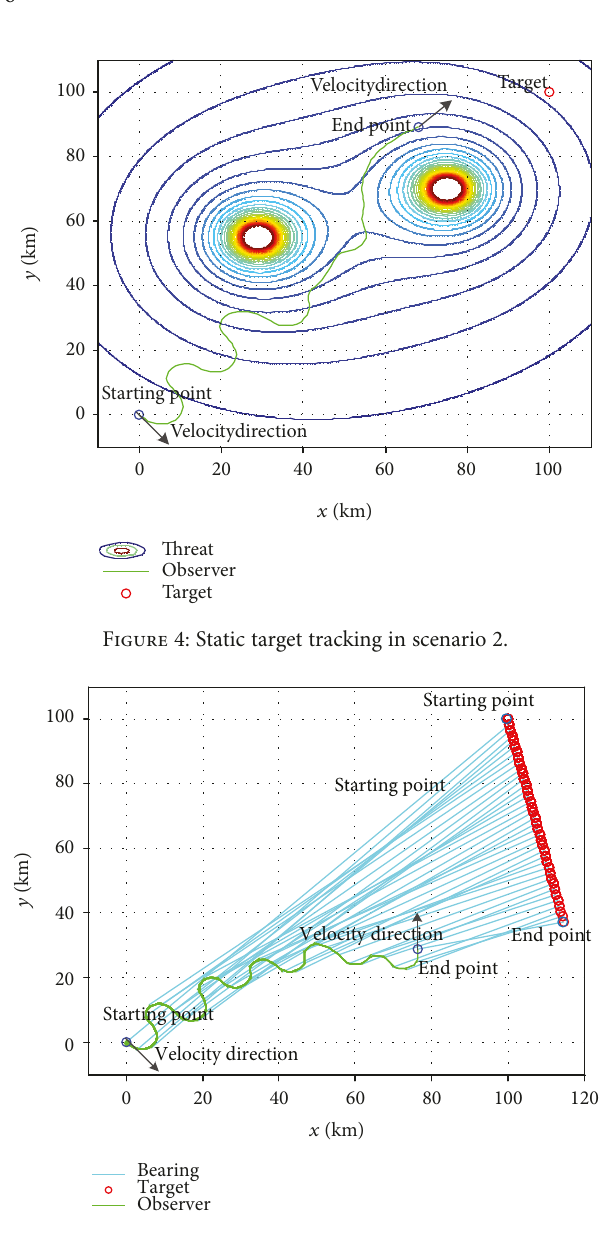
Figure 5: Moving target tracking in scenario 3.